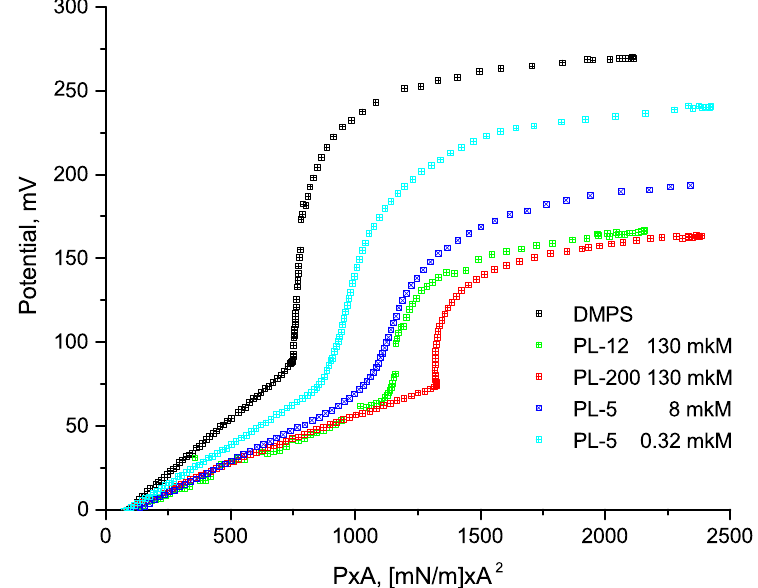
Figure 2. Changes in Volta potential measured for DMPS monolayers in the presence of polylysines as a function of the two-dimensional compression energy of the monolayer. For all curves, the zero value of the potential is taken at the compression point corresponding to the lateral pressure in the monolayer equal to 1 mN/m.